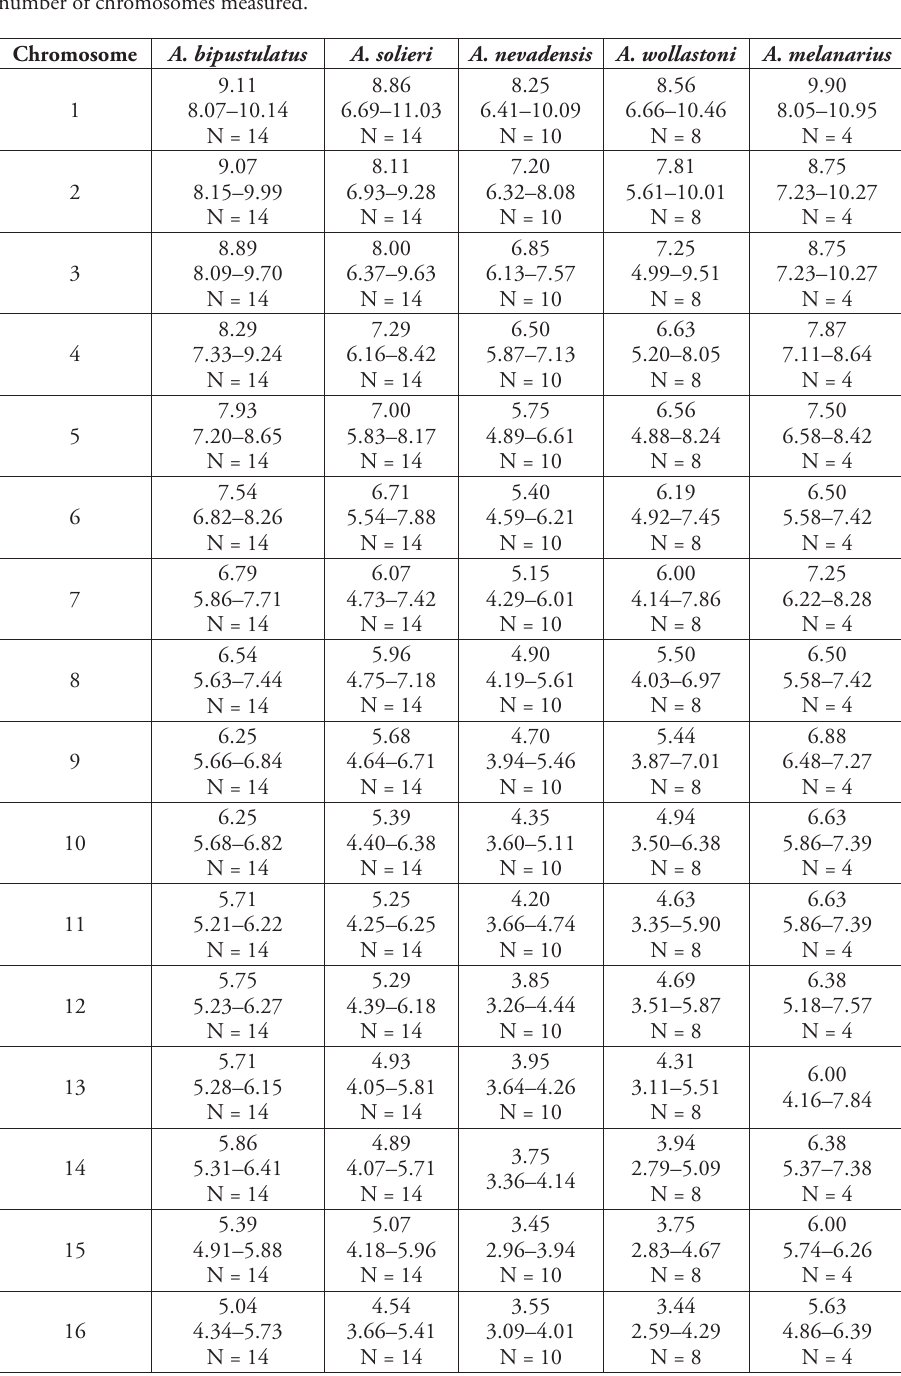
table 2. A. bipustulatus group species, Relative Chromosome Length. Mean, 95% confidence intervals, number of chromosomes measured.